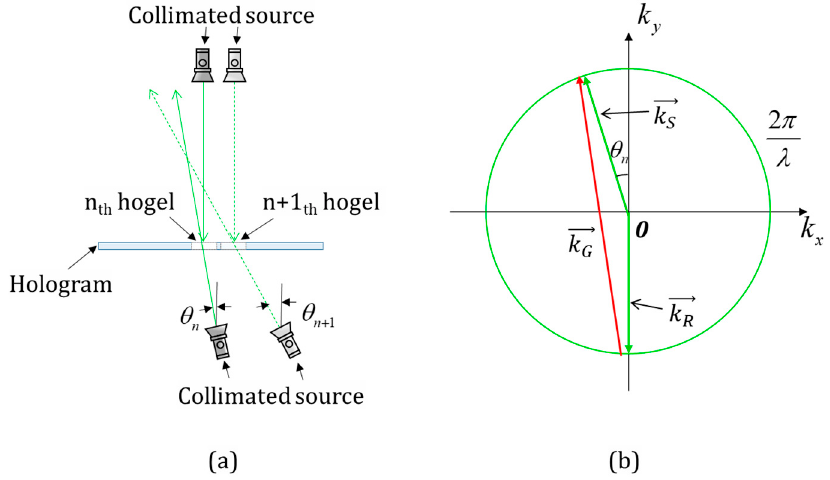
Figure 2. The proposed HOE generation method for IHP. ( a ) Hologram printer concept and ( b ) k -vector diagram at n th hogel.